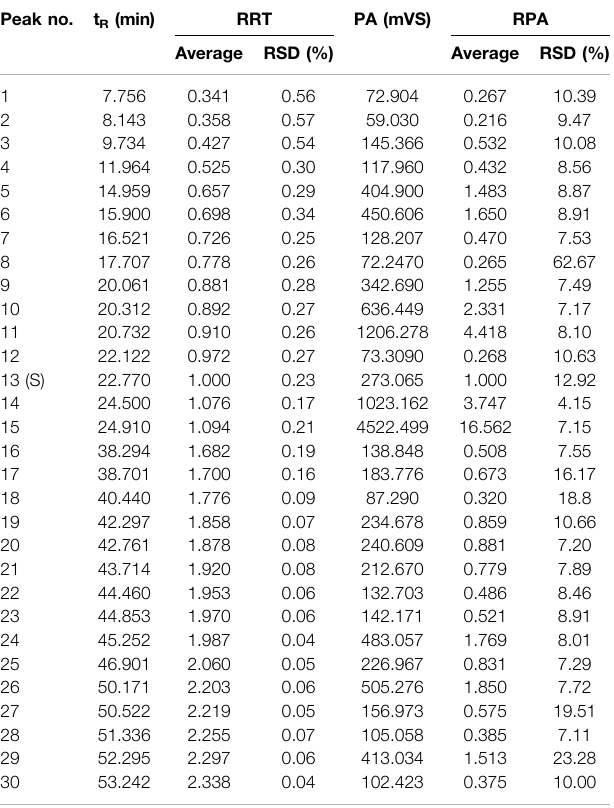
TABLE 2 | The retention time (t R ), relative retention time (RRT), peak area (PA) and relative peak area (RPA) of 30 characteristic fi ngerprint peaks in GDD. Peak no. t R (min)